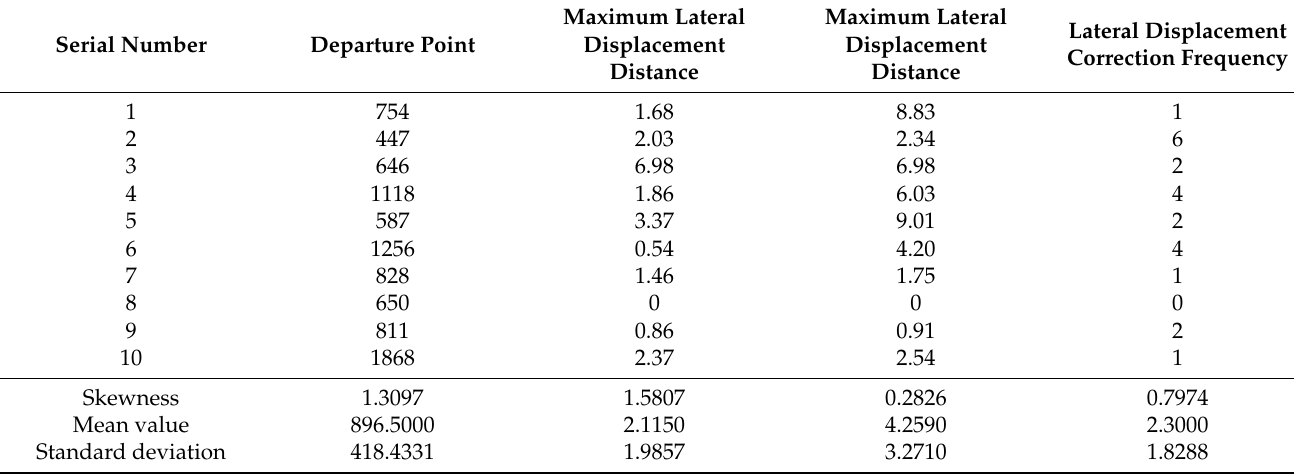
Table 11. Horizontal offset simulation data.